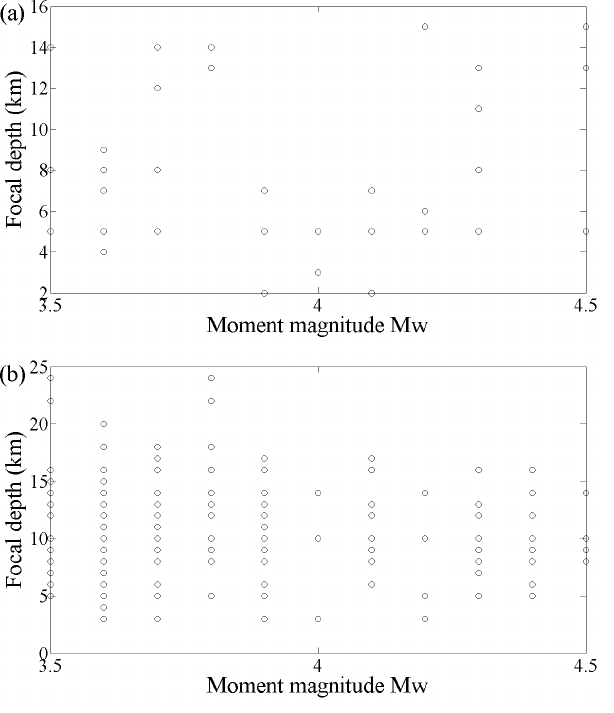
Figure 3. M w hypocentral distance distribution of small earthquake records in (a) Sichuan region and (b) Yunnan